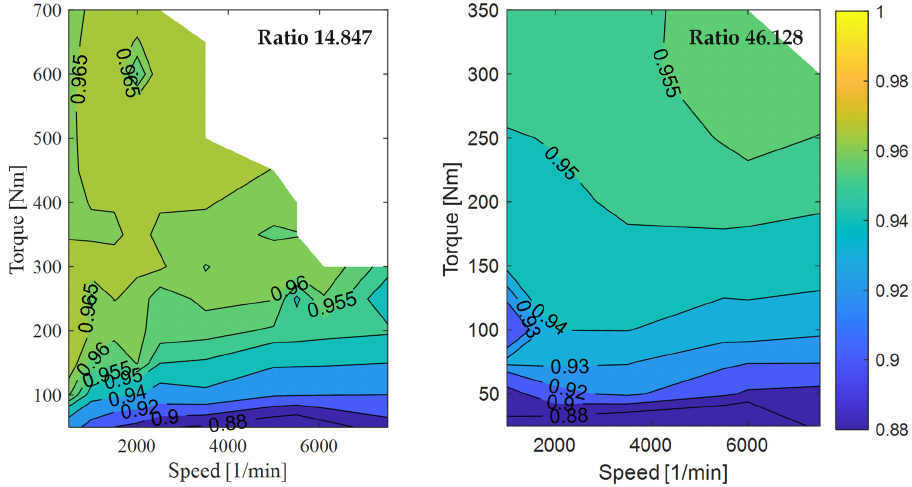
Figure 9. Measured efficiency maps of the prototype electric drive axle.